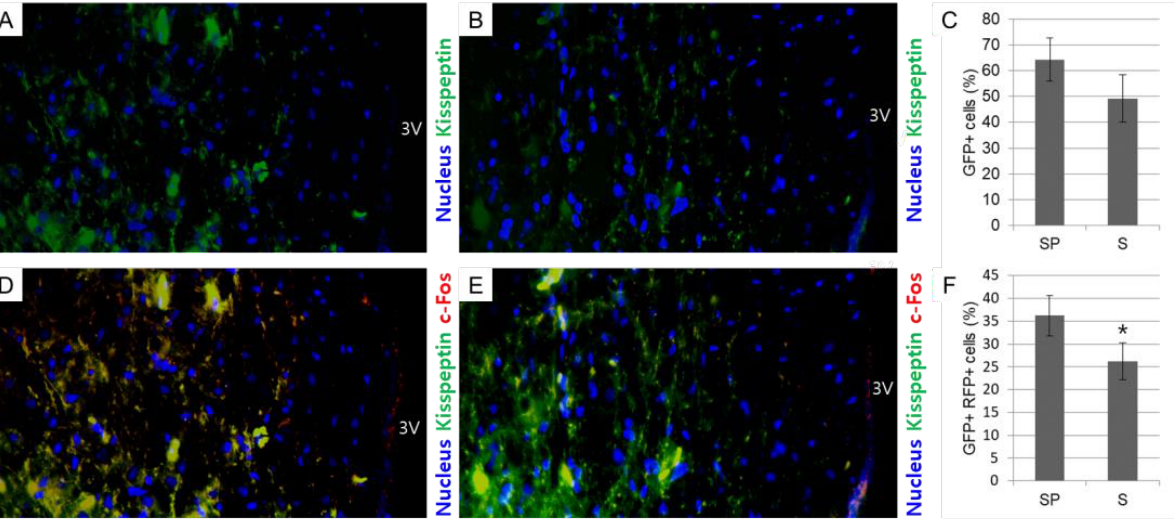
Figure 4. The activity of kisspeptin neurons in the region of PeN near 3V of the hypothalamus in the follicular phase of domestic sows in different seasons. Fluorescent immunohistochemical staining is conducted to identify nucleus (blue), kisspeptin positive cells (GFP), and c-Fos positive cells (RFP) in the region of PeN near 3V. Kisspeptin-positive cells (%) are more abundant in the summer group ( A – C ). Kisspeptin neurons co-expressing c-Fos (%) are significantly ( p < 0.05) reduced in the summer group ( D – F ). Significant differences ( p < 0.05) are indicated by superscripts * at the top of the bars. The fluorescent immunohistochemical staining is conducted using 18 samples ( n in SP = 9 and n in S = 9). Graphs are presented as mean ± SEM. Magnification: × 200. Abbreviations: PeN, periventricular nucleus; 3V, the third ventricle; GFP, green fluorescent protein; RFP, red fluorescent protein.